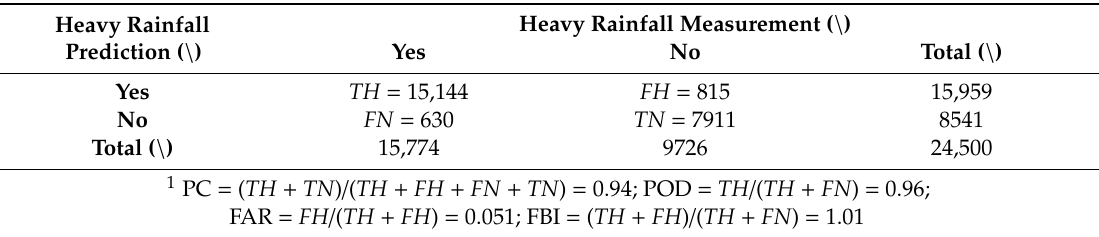
Table 4. The comparisons of predicted heavy rainfall with measurements for each grid cell in the rainfall